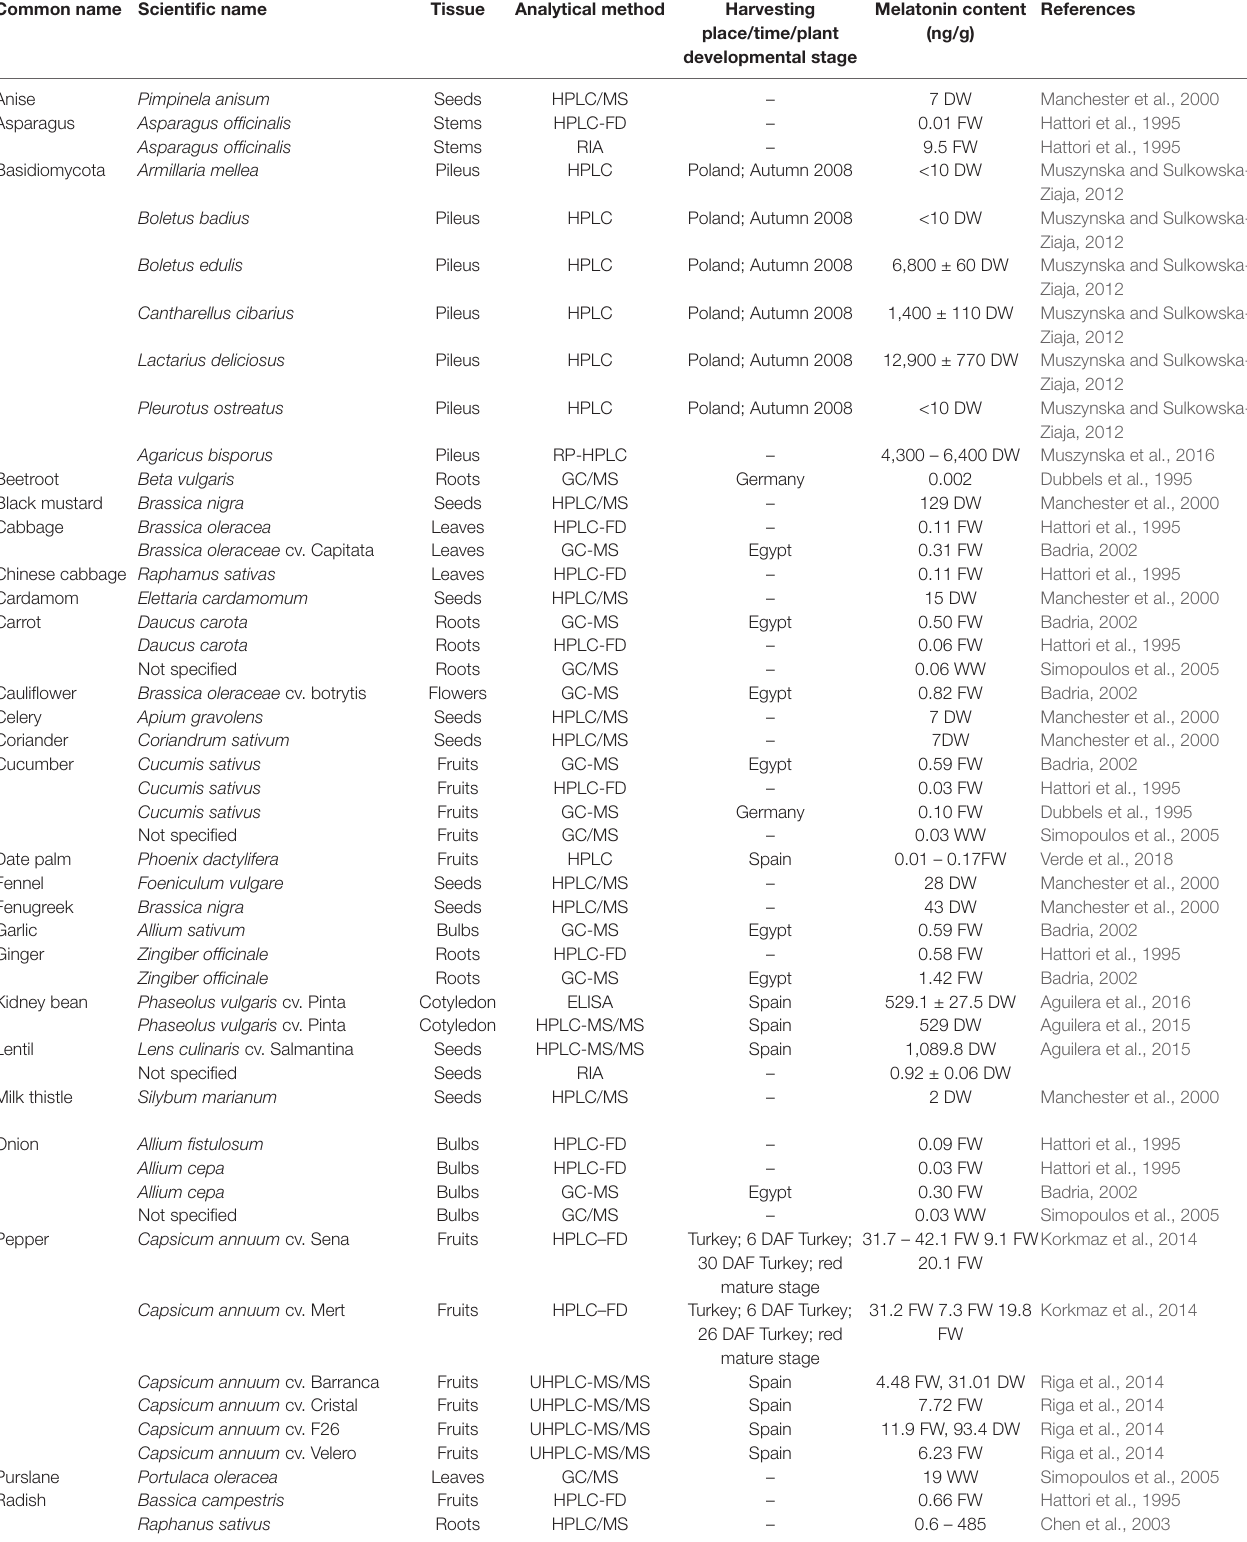
TABLe 2 | Contents of endogenous melatonin in different post-harvest